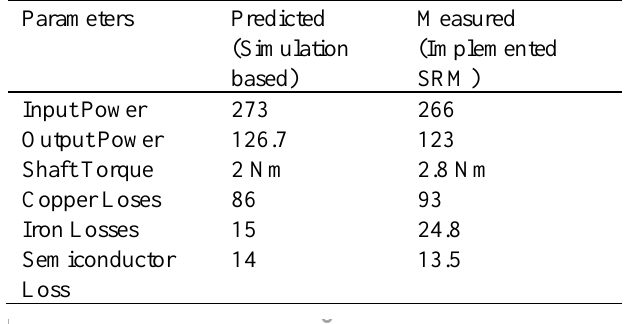
Fig. 7. Representation of current in single pulse mode at 30 0 conduction angle